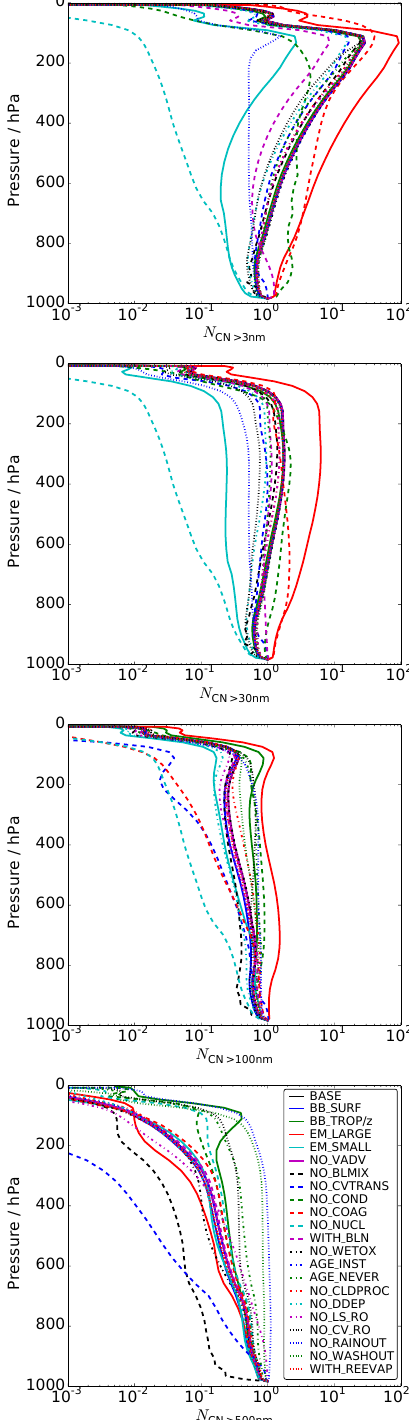
Figure 4. Annual- and global-mean vertical profiles of condensa- tion nuclei (CN) above 3, 30, 100 and 500nm dry diameter from the HadGEM3–UKCA sensitivity-test simulations, normalised to the mixing ratio at the